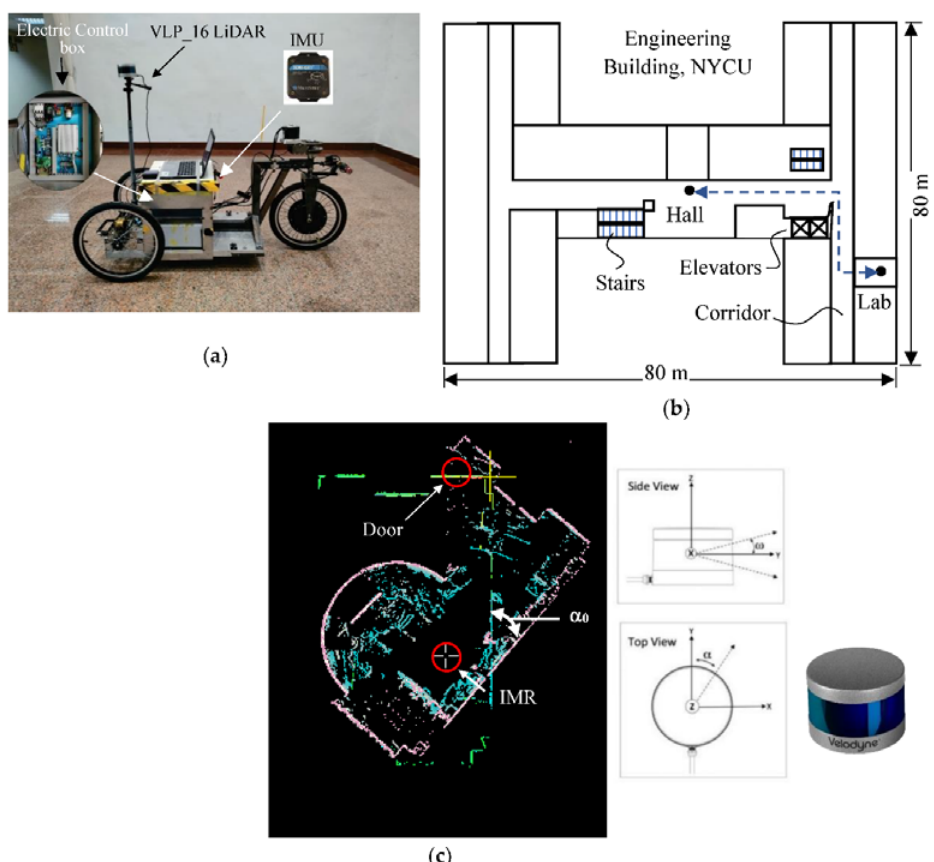
Figure 11. ( a ) The IMR, ( b ) top view of the floor, ( c ) calibration of LiDAR